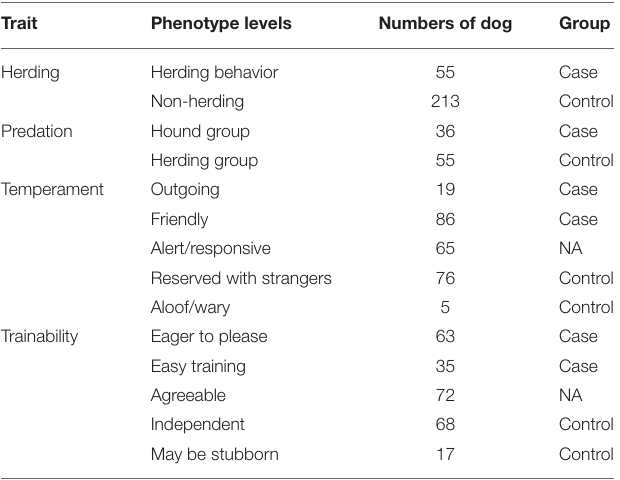
TABLE 1 | Summary of dog behavioral phenotypes used in genome-wide association study (GWAS) analysis.